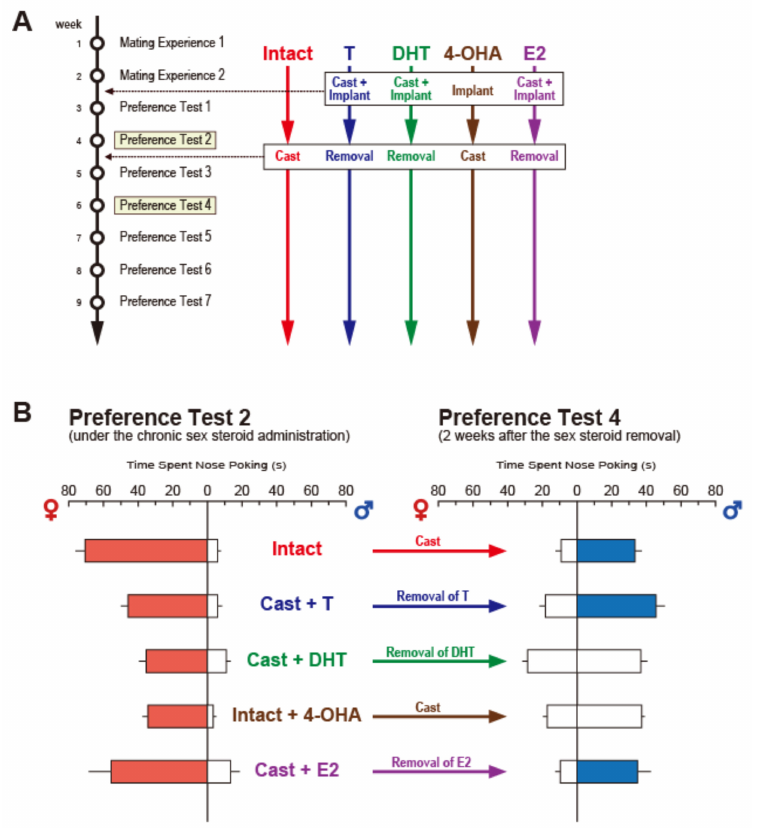
Figure 3. We examined the hormonal influence on the transient reversal of sexual preference observed after castration in male rats [57]. ( A ): in the study, all male rats received mating experience sessions twice weekly followed by seven preference tests. The intact group was castrated after the second preference test; T, DHT, and E2 groups were castrated a week before the first preference test and simultaneously implanted with Silastic capsules containing T, DHT, and E2, respectively. 4-OHA group received a subcutaneous implantation of a Silastic capsule containing a steroidal aromatase inhibitor, 4-OHA, a week before the first test and were castrated after the second preference test. ( B ) shows only the results in preference tests 2 and 4 as the most important points in this experiment. The DHT and 4-OHA groups showed a lack of estrogen after treatment, resulting in no reversed preference after steroid supply ablation. Colored bar in each column of ( B ) indicates significantly longer time in nose-poking toward females than males (red) or toward males than females (blue) ( p < 0.05). Reprinted with permission from Ref. [57]. Copyright 2015